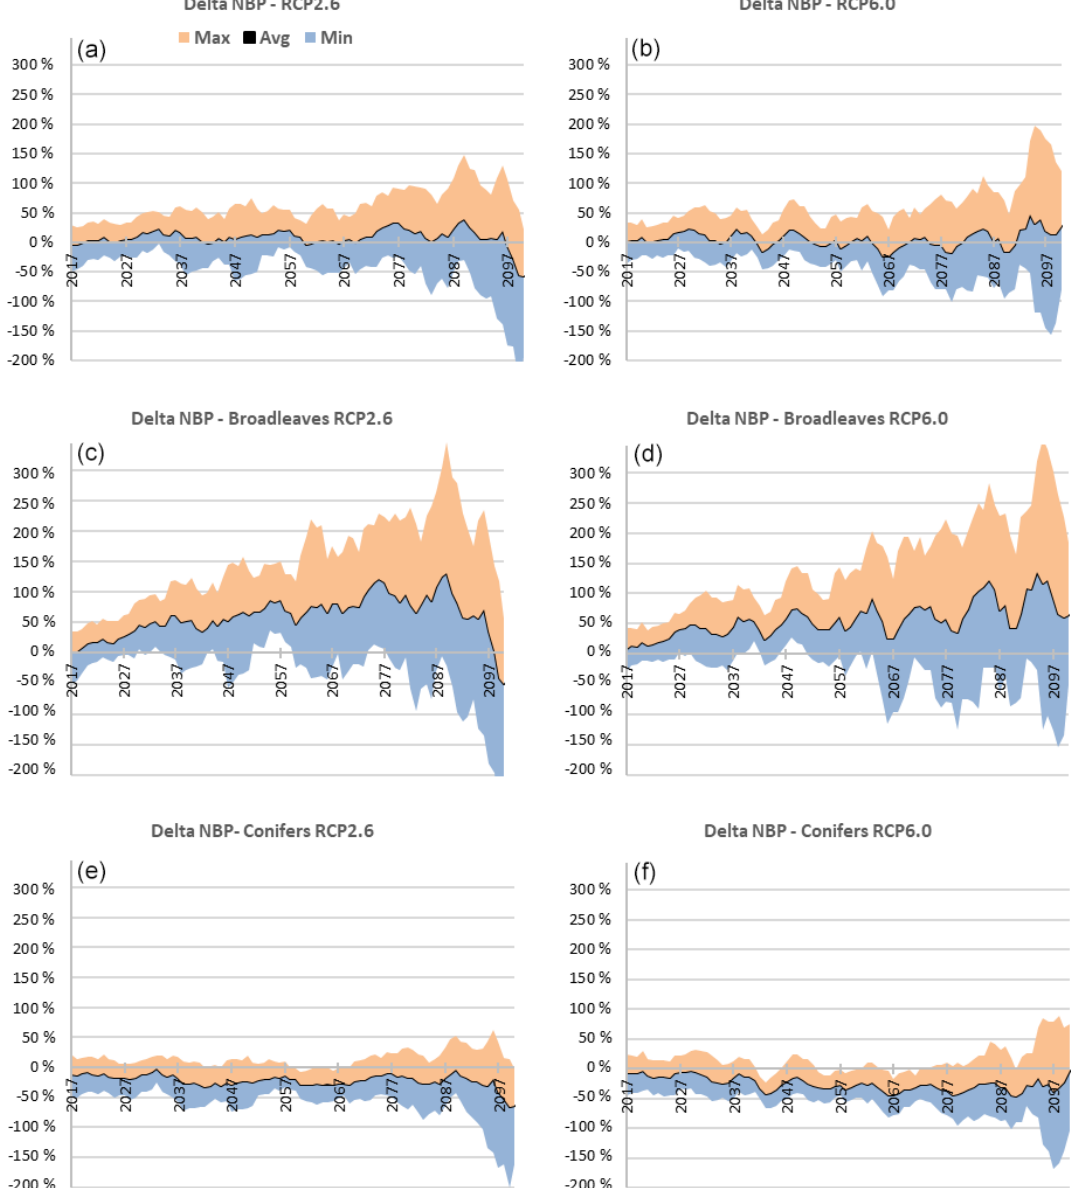
Figure 8. Average annual rate of variation in the net biomass production (NBP), compared to the RS, as derived from the four climate models, at the EU level (a, b) , for broadleaves and for conifers, under different RCP scenarios. Minimum (min) and maximum (max) percentage values correspond to the interval between the minimum and maximum difference with the RS for each year. All values are reported as 5-year moving